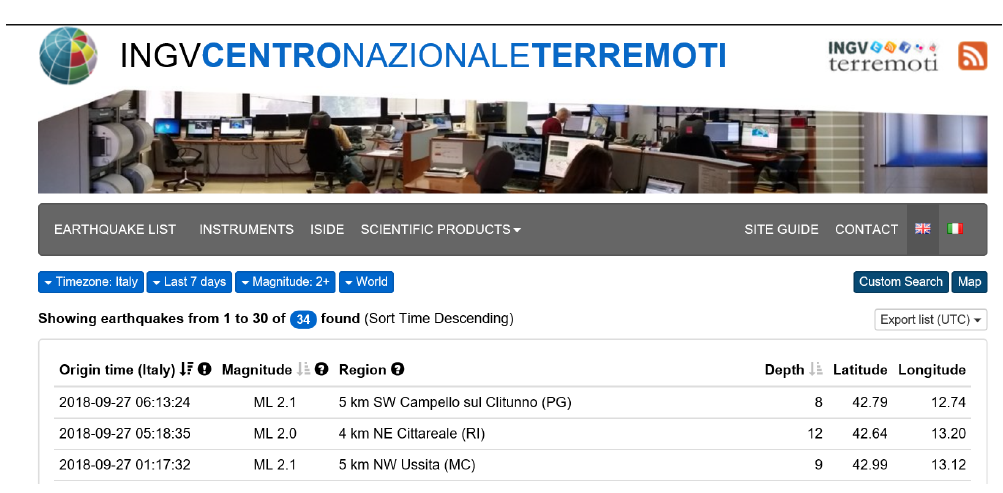
Figure 6. The INGV page about recent earthquakes (http://cnt.rm.ingv.it/).